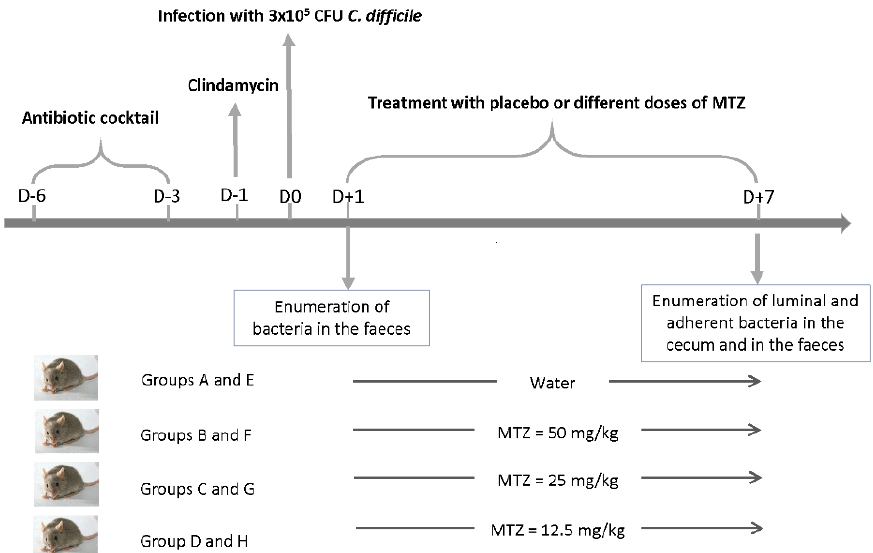
Figure 6. Experimental design of the conventional mouse model to study the impact of different doses of MTZ on the cecum colonization by VPI 10463 and CD17-146. The antibiotic cocktail contained kanamycin (40 mg/kg), gentamycin (3.5 mg/kg), colistin (8.5mg/kg), MTZ (21.5 mg/kg) and vancomycin (4.5 mg/kg). The clindamycin was administrated intraperitoneally (10 mg/kg). The mice were divided into 8 groups, 6 mice per group: four groups (A – D) infected with VPI-10463 and four groups (E – H) infected with CD17-146.